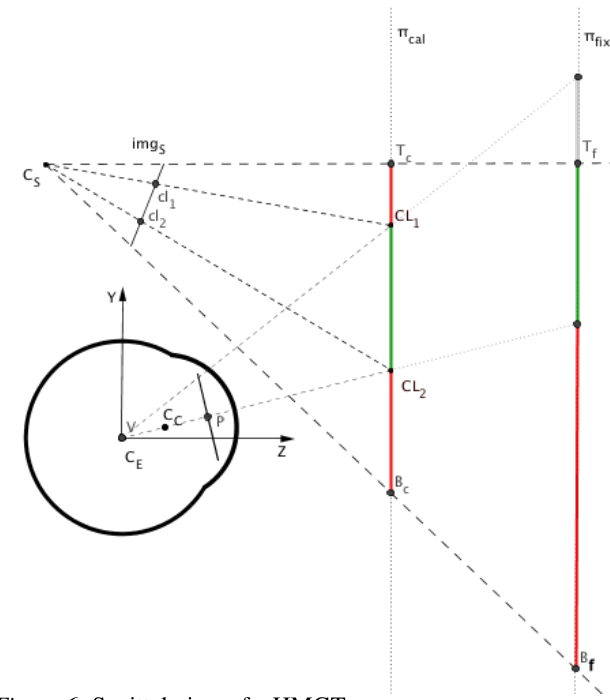
Figure 6 . Sagittal view of a HMGT